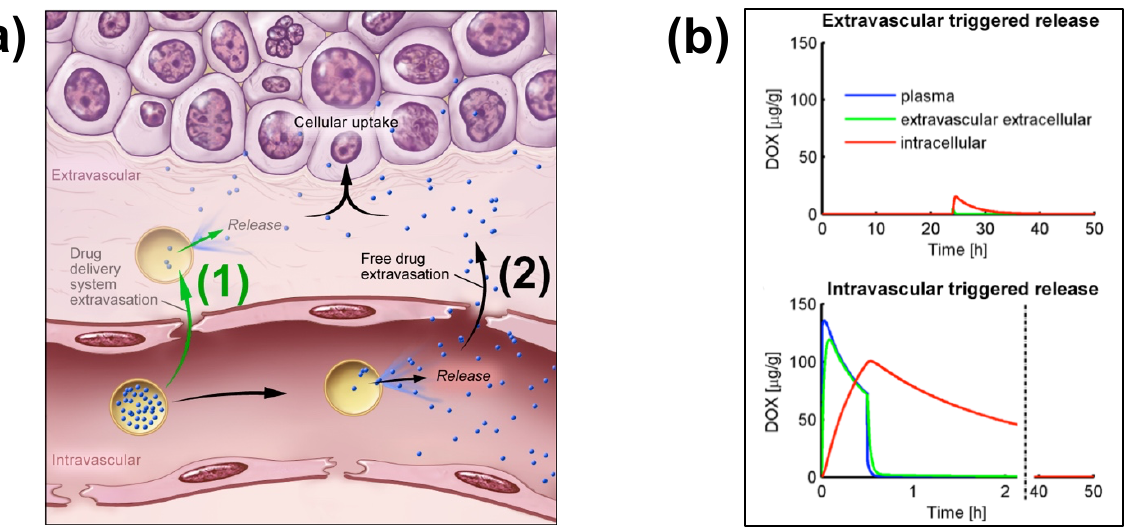
Figure 2. Extra- and Intra-vascular triggered release. a) (1) Traditionally, nanoparticle DDS have been based on passive tumor tar- 79 geting due to enhanced permeability and retention (EPR), where drug is released following extravasation of the DDS. (2) For TSL with intravascular triggered release, EPR is not relevant: TSL enter the tumor microvasculature of the target region where the re- lease trigger (i.e., hyperthermia) is present, and release the contained drug within the vasculature. The released drug extravasates rapidly into tissue and is then taken up by cancer cells. b) Top graph: Concentration dynamics in plasma, interstitial, and intracellu- 83 lar compartments during extravascular triggered release. TSL were allowed to accumulate for 24 h in the tumor based on EPR, fol- lowed by hyperthermia triggered release. Bottom graph: Concentration dynamics during intravascular triggered release. 30 min hyperthermia was applied immediately after TSL administration. Concentration increases in plasma due to drug release. Released drug then extravasates into interstitium (extravascular extracellular space), where it is taken up by cells. Figure a) reproduced from 87 [20] (published under CC BY 4.0 license). Figure b) reproduced from [22] (published under CC0 license).